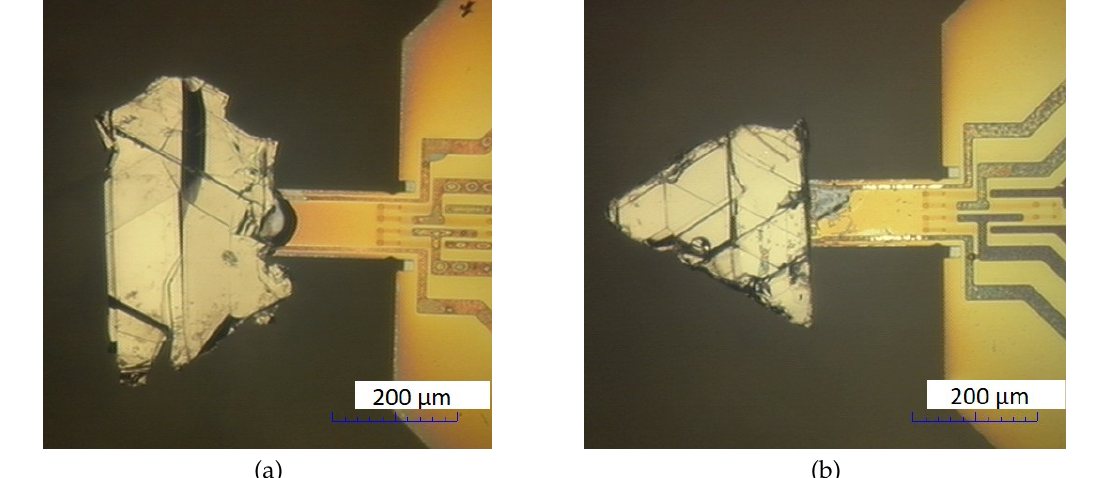
Figure 5. Natural graphite flakes on the tips of the cantilevers. The sample thickness was ( a ) 1.2 µ m and ( b ) 6.9 µ m. The other sample dimensions can be taken from the pictures using the scale bar, which indicates 200 µ m. The bend seen in picture (a) does not represent a large portion of the graphite flake, but it comes from a small part just at the sample surface. It represents an insignificant contribution to the total sample mass (or volume) affecting less than 1% the absolute value of the susceptibility. This is estimated through side